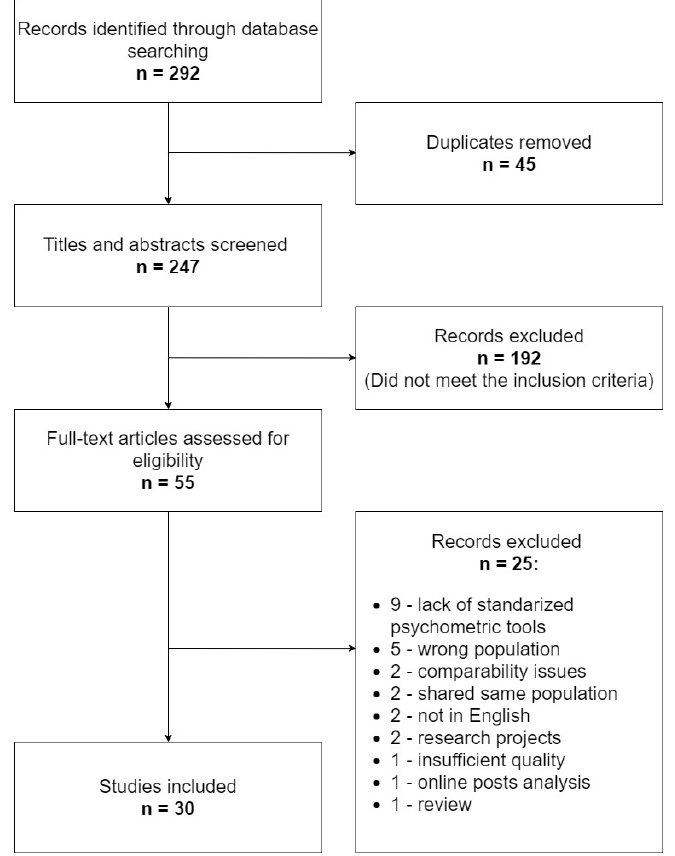
Figure 1. Search flowchart for the selection of articles. Table 1. Characteristics of the selected